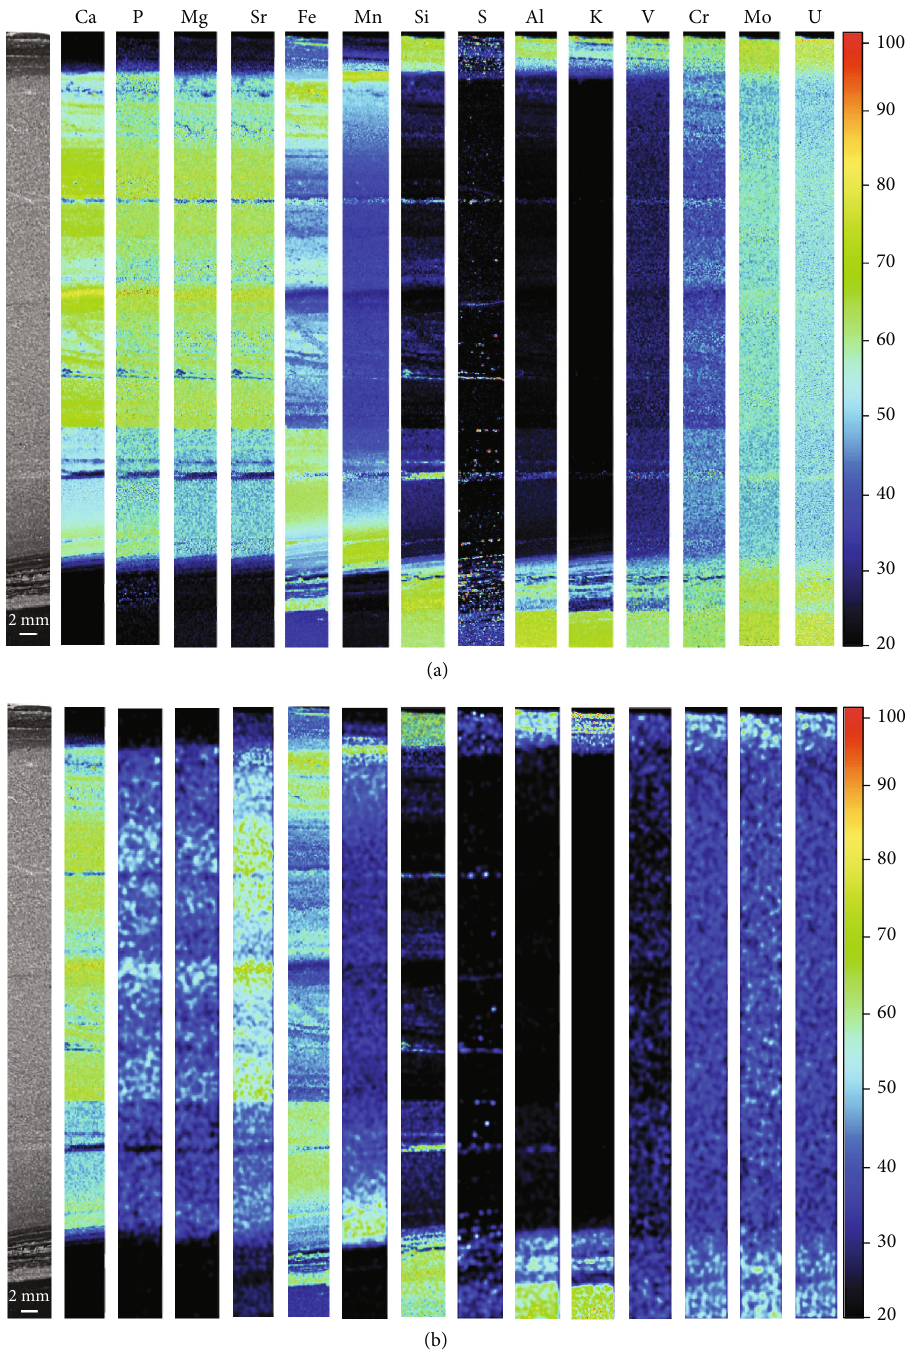
Figure 8: Multielement imaging of area B in Figure 1(d) with a single-point exposure time of 300ms (a) and 4ms (b), respectively. All images share the same color